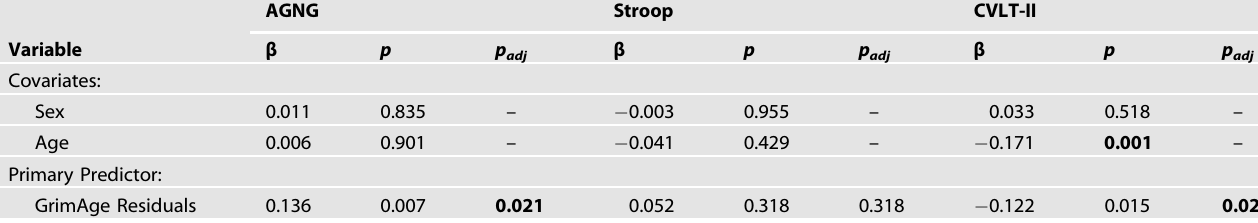
Table 3. GrimAge residuals as a predictor of neuropsychological constructs.